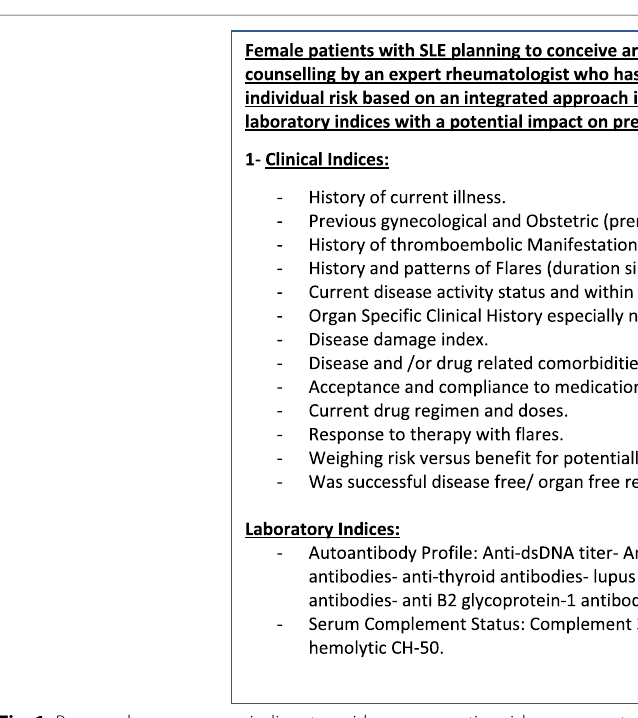
Fig. 1 Proposed consensus on indices to guide preconception risk assessment and conception planning in women with SLE